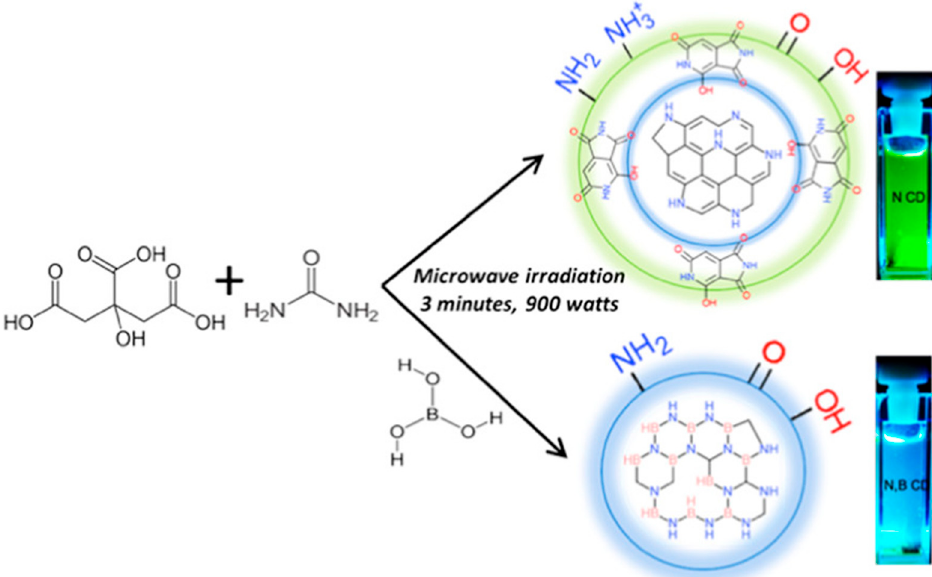
Figure 7. The synthesis of N-CDs and NB-CDs and the corresponding photographs under UV-light irradiation (reprinted with permission from [112], 2019, American Chemical Society).